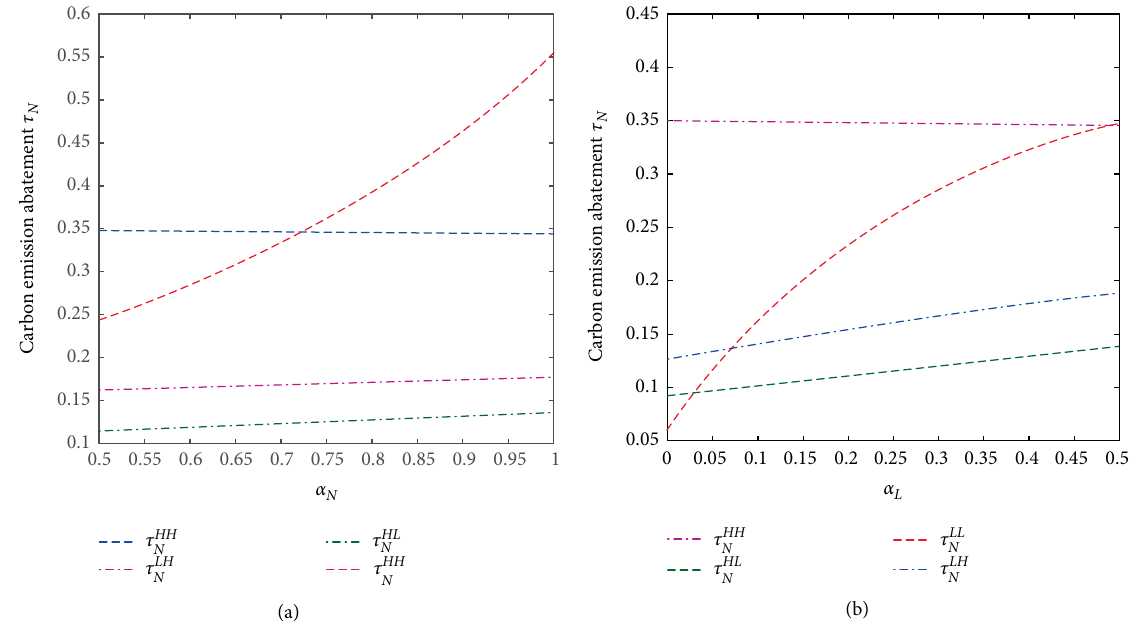
Figure 5: (a) Impact of 𝛼